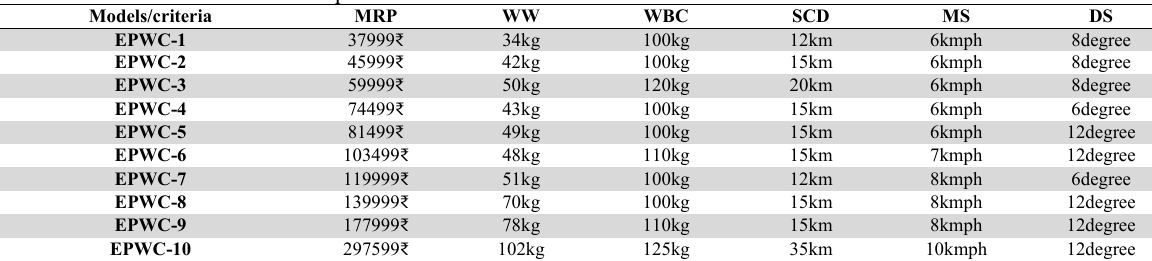
Selected EPWC models with their specifications